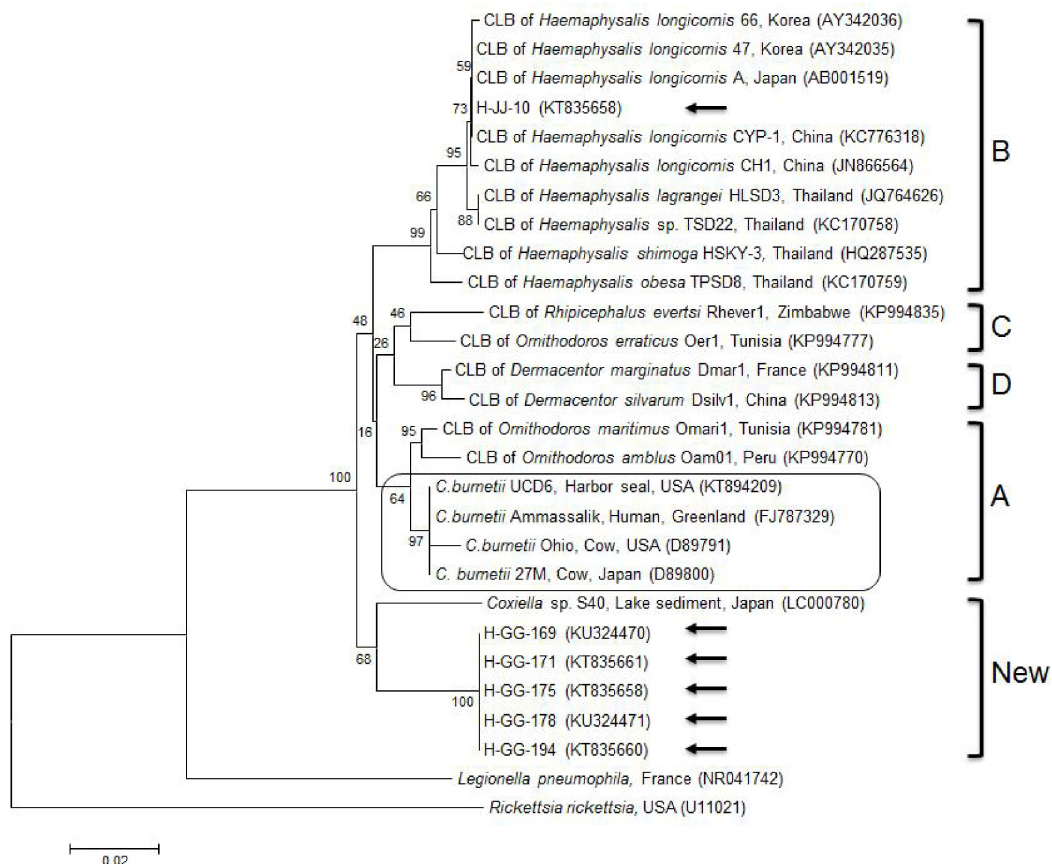
Fig 3. Phylogenetic tree constructed using Kimura/neighbor-joining methods based on 16S rRNA sequences of Coxiella . The four clades (A – D) of Coxiella are categorized. The sequences of Coxiella -like bacteria obtained in this study are marked using arrows. The C . burnetii group is found within clade A. The accession numbers of sequences obtained from GenBank are shown with the sequence names and countries of origin. Numbers on the branches indicate bootstrap support (1,000 replicates). Scale bar indicates a phylogenetic distance of 0.02 nucleotide substitution per position. CLB = Coxiella -like-bacteria.